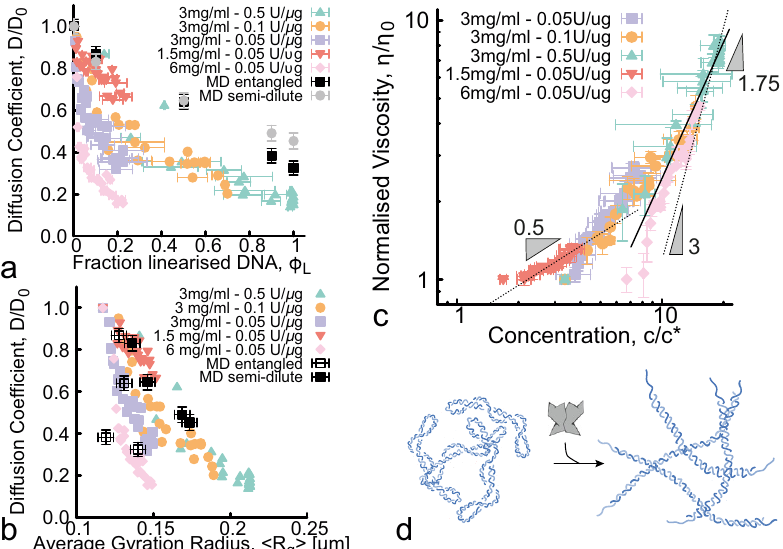
Fig. 3 | Mapping changes of topology and conformational size onto fl uid viscosity. a Normalised diffusion coef fi cients D / D 0 versus fraction of linearised DNA ϕ L , as measured via microrheology (coloured data points) and MD simula- tions (black data points), show slowing of DNA mobility with increasing ϕ L that is stronger for higher DNA concentrations. The discrepancy between experiments and simulations may be due to the fact that experiments have a population of relaxed ring DNA not present in simulations, which may be more prone to threadings. b Data shown in a plotted against the average radius of gyration 〈 R g 〉 measured in experiments (colours) and simulations (black), demonstrating that showed that D ~ c − 1.75 for 11, 25 and 45kbp ring and linear DNA at concentrations above~6 c* , in line with reptation model predictions 67,68 . Below~6 c* , diffusion coef fi cients followed D ~ c − 0.5